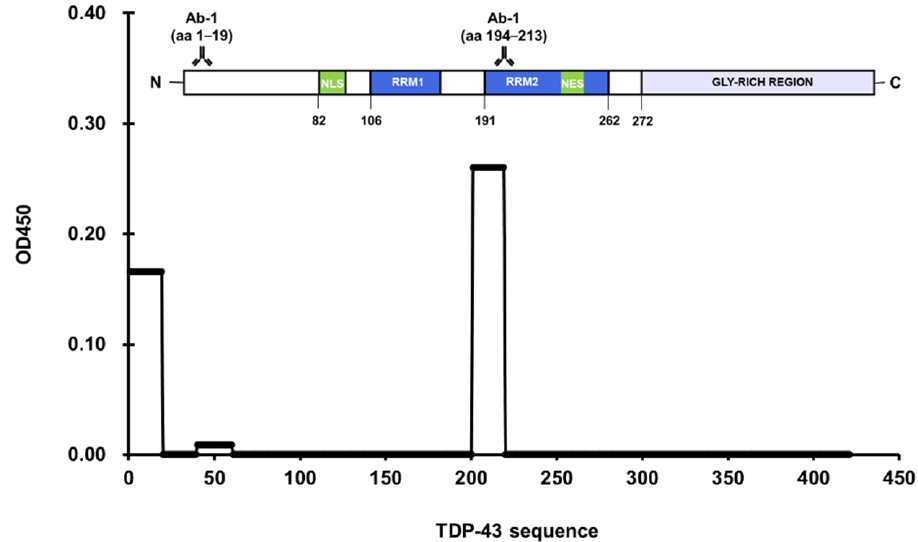
Figure 4. Significant absorbance values were found in regions aa 1–19 and aa 194–213 for polyclonal anti-TDP-43 antibody